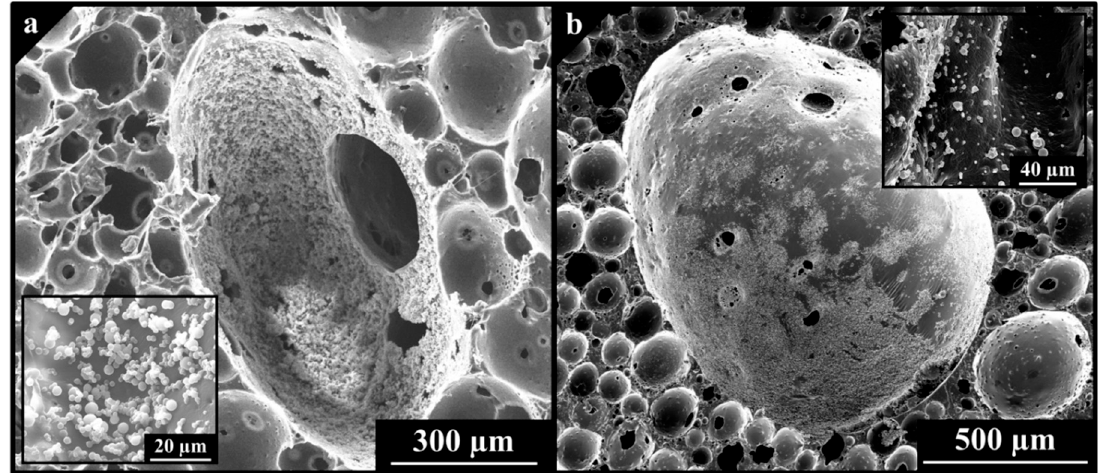
Figure 4. SEM micrographs of the cured foam samples showing the polyurea microspheres on ( a ) EML227 and ( b ) EML350 internal cell walls leading to the reinforcement effect. EML227 and ( b ) EML350 internal cell walls leading to the reinforcement e ff